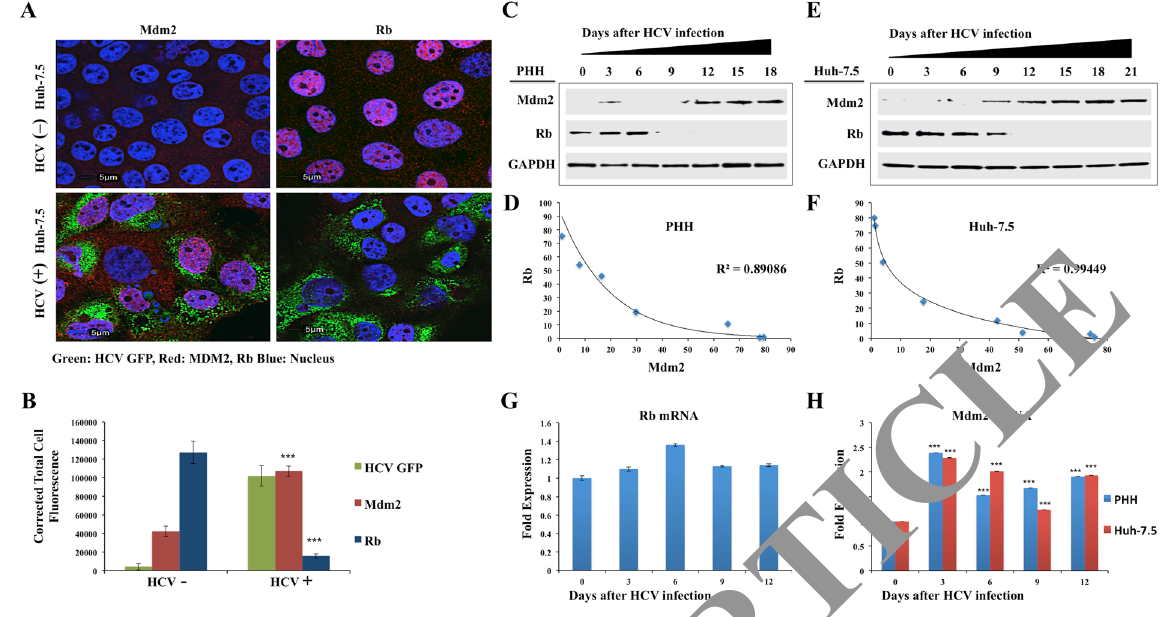
Figure 5. Persistent HCV replication induces Mdm2-mediated degradation of Rb tumor suppressor. (A) Colocalization studies by confocal microscopy between HCV-GFP and nuclear expression of Mdm2 and Rb in infected Huh-7.5 cells at day 12. (B) Fluorescence intensity of three areas was measured by ImageJ software, indicating HCV infection induces Mdm2 but degrades Rb. (C) Cell lysates were prepared from infected PHHs at indicated time points, and were examined for the expression of Mdm2 and Rb by Western blotting. GAPDH levels were examined for comparison. (D) Band intensities of Mdm2 and Rb were measured using ImageJ software andR 2 values were determined by excel software. ( E ) The expressions of Rb and Mdm2 were measured in the infected Huh-7.5 cells at indicated time points by Western blotting. ( F ) Band intensities of Mdm2 and Rb were measured using ImageJ software and R 2 values were determined by excel software. (G) Real-time RT-PCR analysis of Rb mRNA levels of HCV infected Huh-7.5 cells. Rb forward sequence 5 ′ -GGAAGCAACCCTCCTAAACC-3 ′ , reverse sequence 5 ′ -TTTCTGCTTTTGCATTCGTG -3 ′ . ( H ) Real-time RT-PCR shows that Mdm2 mRNA levels are induced in HCV infected PHHs and Huh-7.5 cells. Mdm2 forward sequence 5 ′ -TGTAAGTGAACATTCAGGTG-3, reverse sequence 5 ′ -TTCCAATAGTCAGCTAAGGA-3 ′ . *** P value <